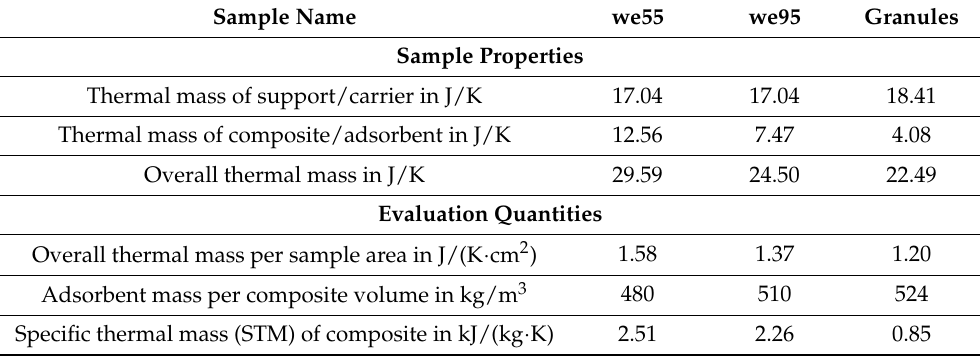
Table 4. Thermal masses and related quantities of the samples.